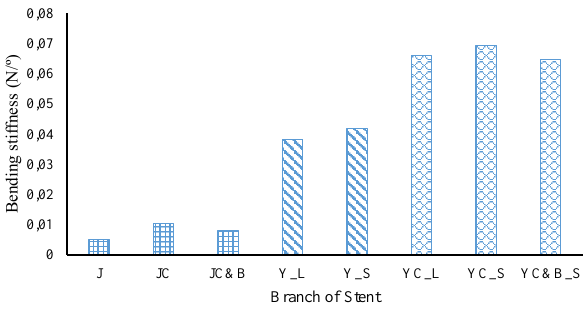
Figure 7: Bending stiffness of branches in both J–shaped and Y- shaped